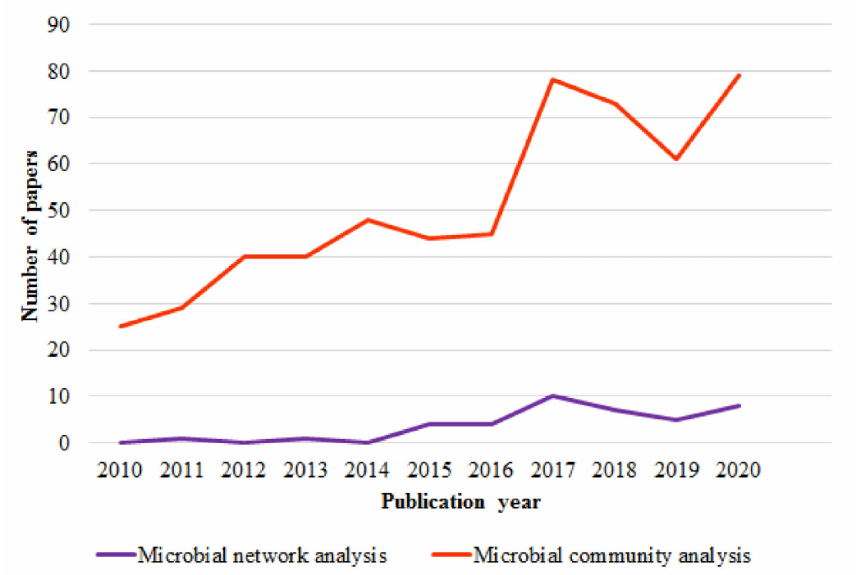
Figure 4. Number of papers reporting microbial community analysis and microbial network analysis in the rumen. Data are based on the Web of Science database (time span: 2010–2020; keywords: “microbial network analysis rumen” and “microbial community analysis